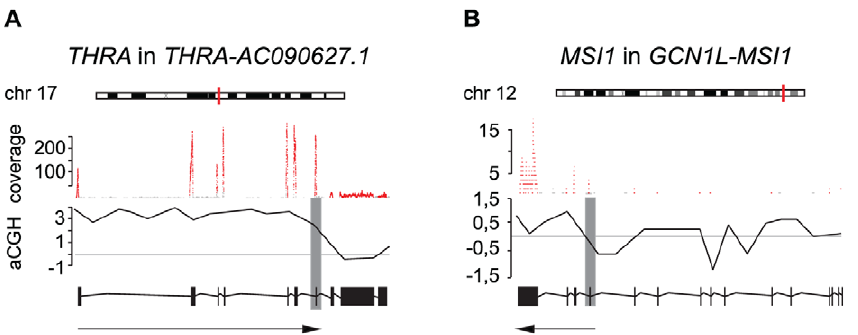
Figure 4. Exclusive expression of fusion partner genes. Exonic expression of THRA in THRA-AC090627.1 (A) and MSI1 in GCN1L-MSI1 (B) is indicated by sequencing coverage (red). Copy number changes measured by aCGH (black lines) in reference to normal copy number (horizontal gray lines), chromosomal positions (vertical red lines on chromosomes) and fusion break points (vertical gray bars) are shown. Transcript structures are indicated below the aCGH profiles with the arrows pointing to the parts of the transcripts taking part in the